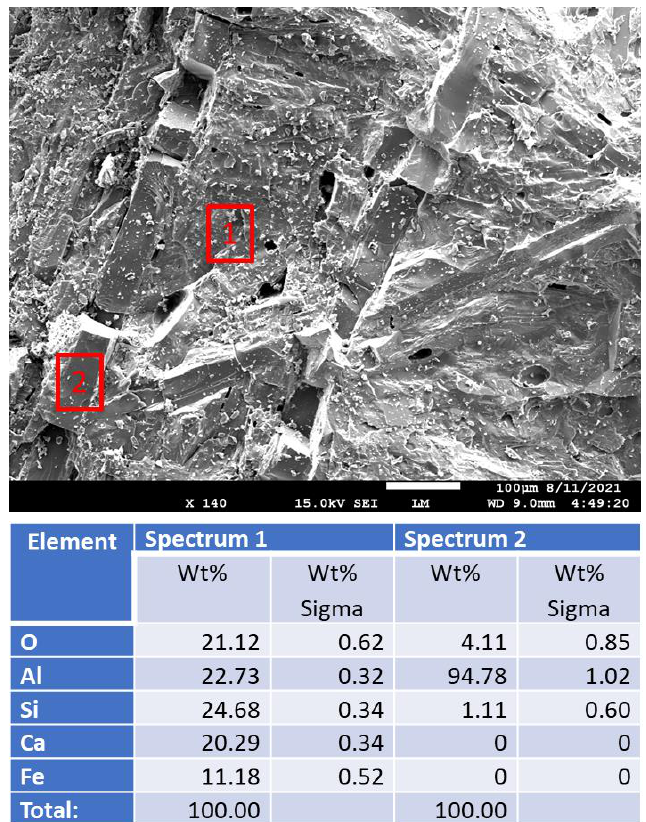
Figure 32. Photomicrographs of mullite samples with the elemental composition of typical sites shown by the red boxes after 3 cycles of thermal shock (one cycle: 600 °C heat → cold water quenching).